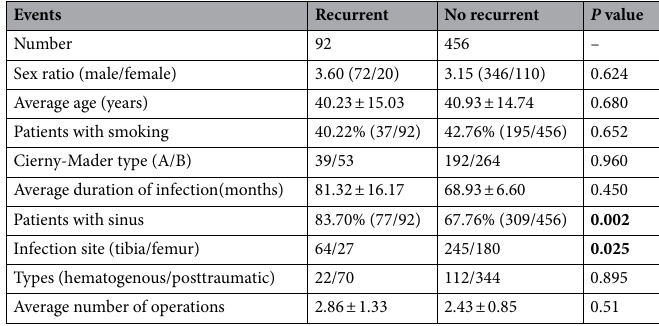
Table 1. Comparisons between the two cohorts of infection recurrent or